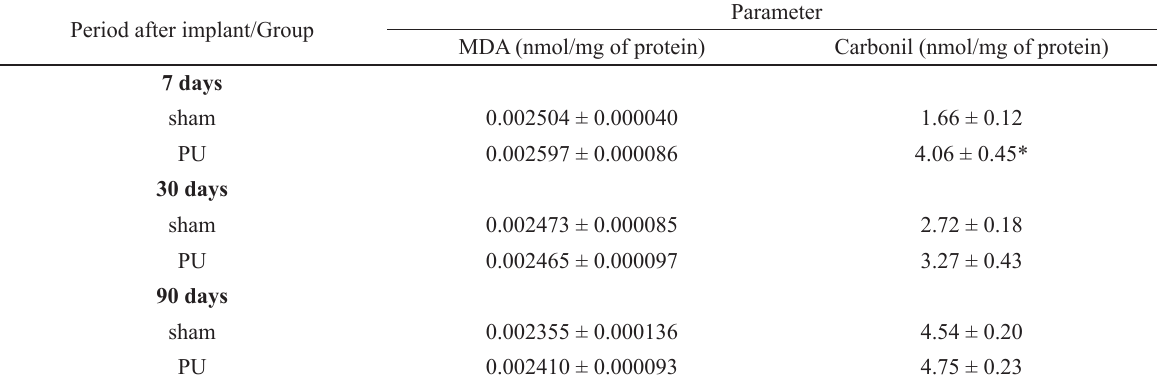
Infl uence on diff erent biochemical parameters of oxidative stress induced by PU implant in the dorsal skin of rats. Period after implant/Group